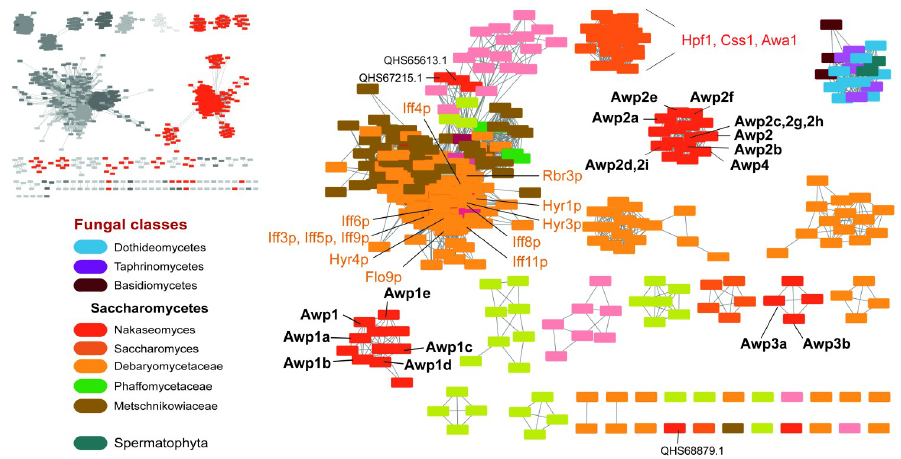
Fig 1. SSN analysis of the class of fungal cell wall proteins of the Awp1/Hyr1/Hpf1-type. Upper left, the SSN of orthologs of Awp1-Awp4 is shown (E-value cut-off 10 − 20 ), which have been accumulated by ten repeated rounds of PSI-BLAST for each before merging the results and removing redundancy prior to SSN-analysis. The Interpro family of ‘N-terminal, hyphally-regulated cell wall proteins’ (IPR021031) is a subset of this SSN. Each of the 4507 nodes (left, E-value cutoff 10 − 20 ) covers sequences with pairwise sequence identities of at least 80% (total: 11737 sequences), 445 nodes (711 sequences) are of fungal (red), the remainder (grey) of bacterial origin. Right, the majority of fungal orthologs are found in Saccharomycetes (E-value cut-off 10 − 25 ). The structurally characterized A-regions of Awp1 and Awp3b fall in two separate C . glabrata subclusters besides the Iff4 subcluster. In C . albicans , at least twelve paralogs of the same domain type can be identified (orange labels), in S . cerevisiae strains Awa1, Hpf1 and Css1 form a common subcluster. The nodes are colored by fungal clade, with red being C . glabrata (Nakaseomyces); light orange designated the CTG clade, including Candida albicans